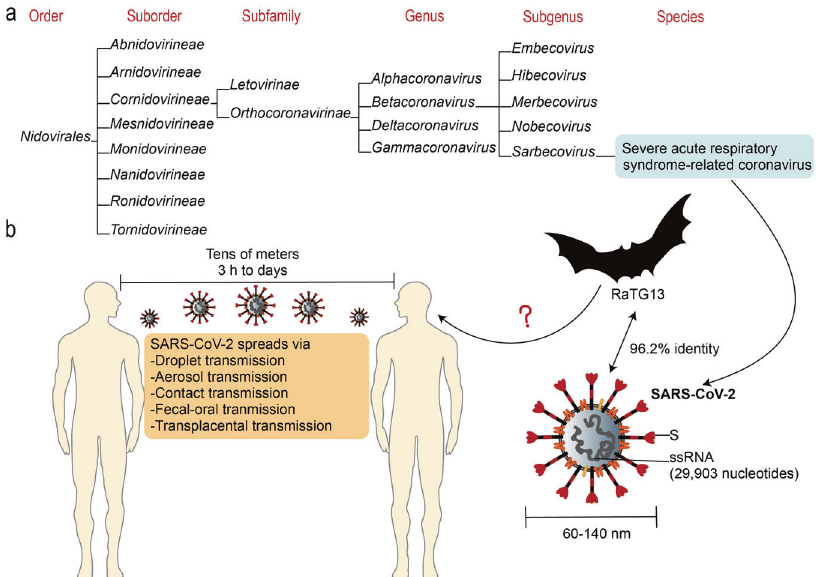
Fig. 3 The causative pathogen, SARS-CoV-2. a The taxonomy of SARS-CoV-2 is shown (from https://talk.ictvonline.org/taxonomy/). b SARS- CoV-2 is ssRNA virus with a diameter of ~60 – 140 nm and whole viral genome sequence of 29,903 nucleotides, and possesses distinctive S protein; 96.2% identity is shown between SARS-CoV-2 and a bat-borne coronavirus, RaTG13. SARS-CoV-2 spreads from human to human via droplet, aerosol, contact, fecal – oral, and transplacental transmissions. Droplets with SARS-CoV-2 can spread up to tens of meters and